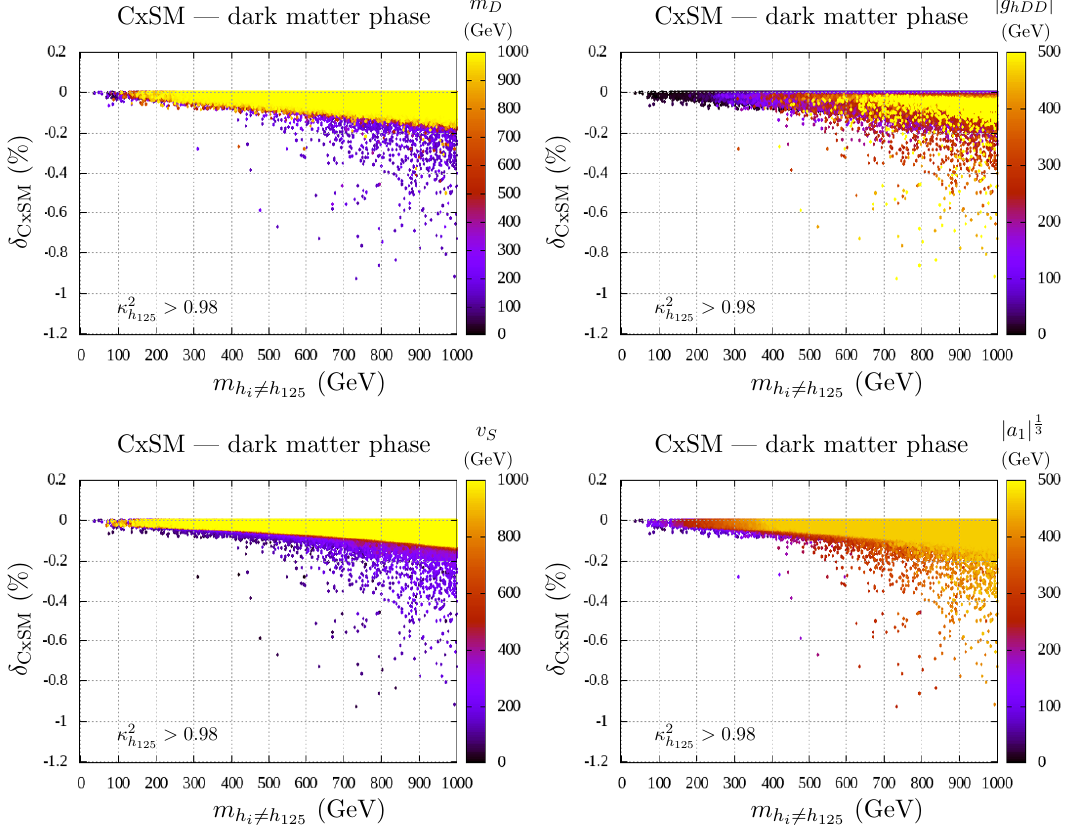
Figure 4 . Parameters dependence of gluon fusion correction in the CxSM-dark : in all panels we present the NLO EW scalar contribution to the correction to gluon fusion production of the SM- like Higgs (vertical axis), versus the mass of the new non-SM like non-dark Higgs boson (horizontal axis), for the dark phase of the CxSM. In the colour scale we have, top left , the dark matter mass; top right , the coupling of the SM-like Higgs to a dark matter pairs; bottom left , the singlet VEV; and bottom right , the linear